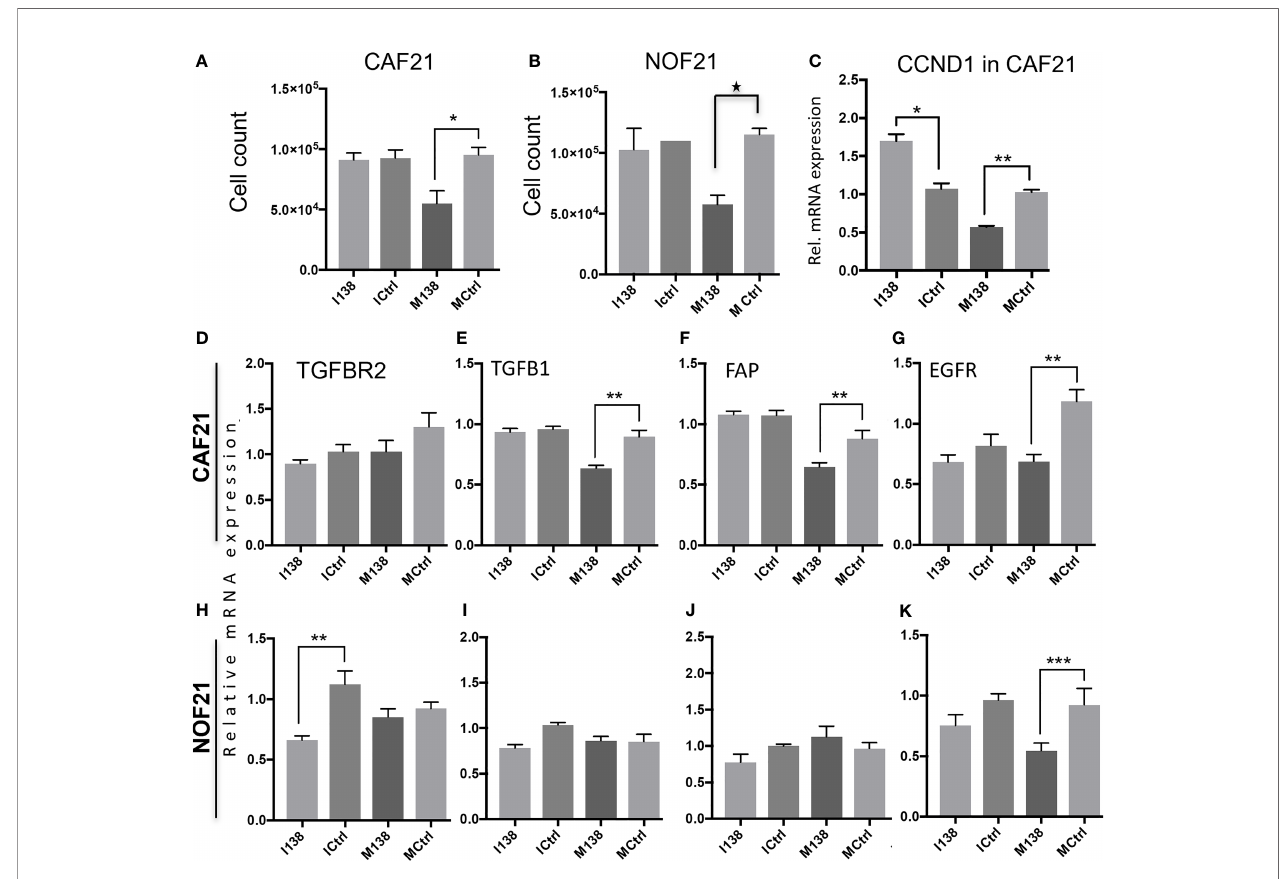
FIGURE 3 | Fibroblasts ’ proliferation and expression of CAF markers in monolayer culture following miR-138 modulation. Proliferation of (A) CAFs and (B) NOFs, (C) regulation of CCND1 transcript in CAFs, and (D – K) other transcripts related to the CAF-phenotype (TGF b 1, TGFBR2, and FAP) and EGFR in CAFs and NOFS 48 h post miR-138 modulation. * Signi fi cant; unpaired t -test p < 0.05. I138: inhibition of endogenous miR-138. M138: mimicking of miR-138 expression. Ictrl and MCtrl: respective controls for inhibitors and mimics. ** p < 0.01, *** p <